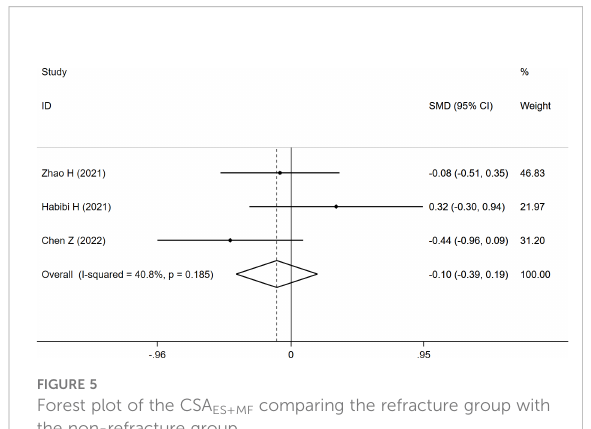
FIGURE 5 Forest plot of the CSA ES+MF comparing the refracture group with the non-refracture